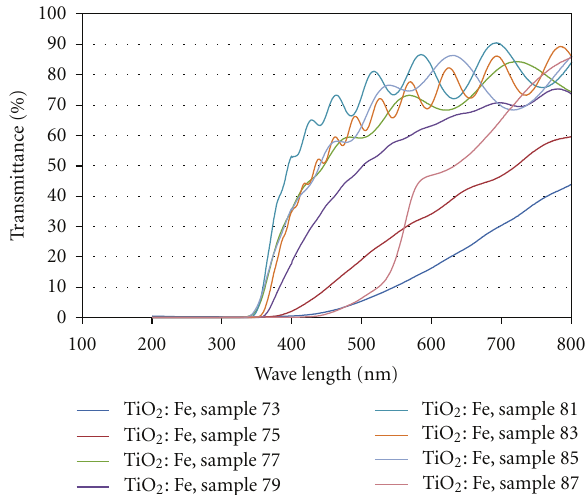
Figure 8: Transmittance UV-Vis spectra of iron doped TiO 2 thin films. Samples 73–77 were prepared from the internal, and Samples 79–87 from the external precursors vapor source.